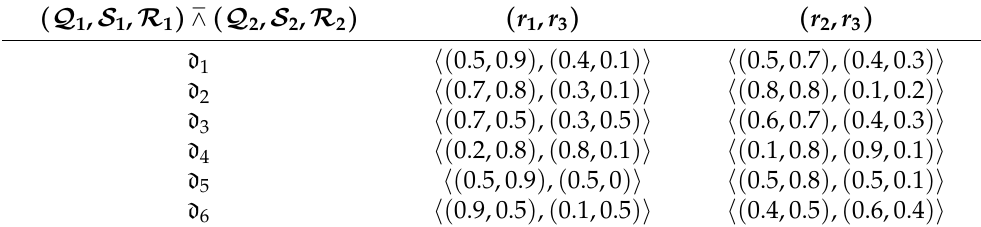
Table 8. Table for the 7-ROFBSS ξ 1 (cid:90) ξ 2 .